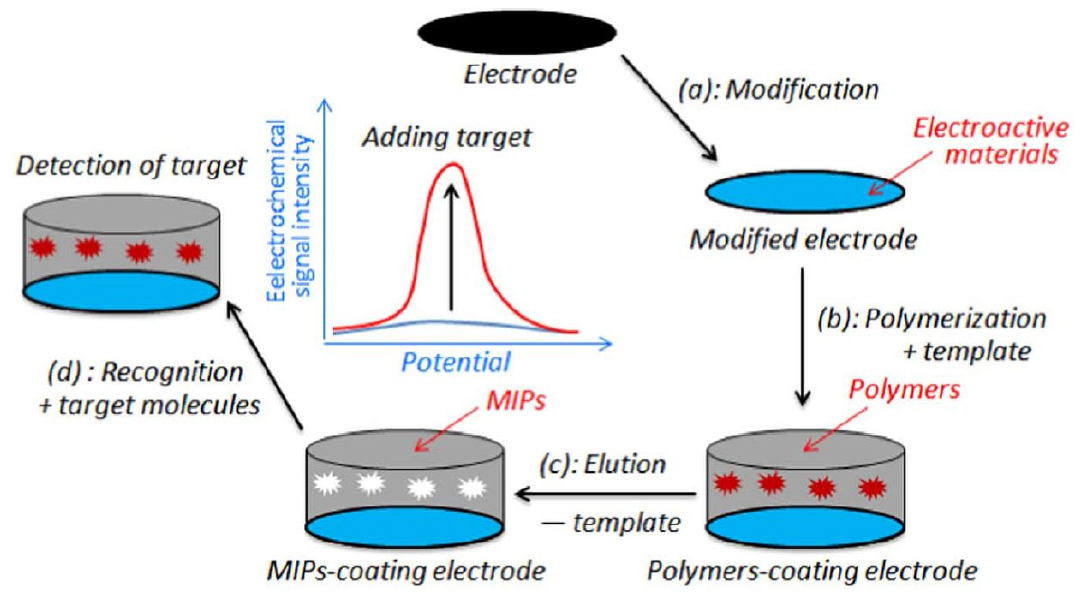
Scheme 1. Workflow of the design and application of eMIPs ‐ based electrochemical sensors. Re ‐ printed with permission from [11]. Copyright 2018